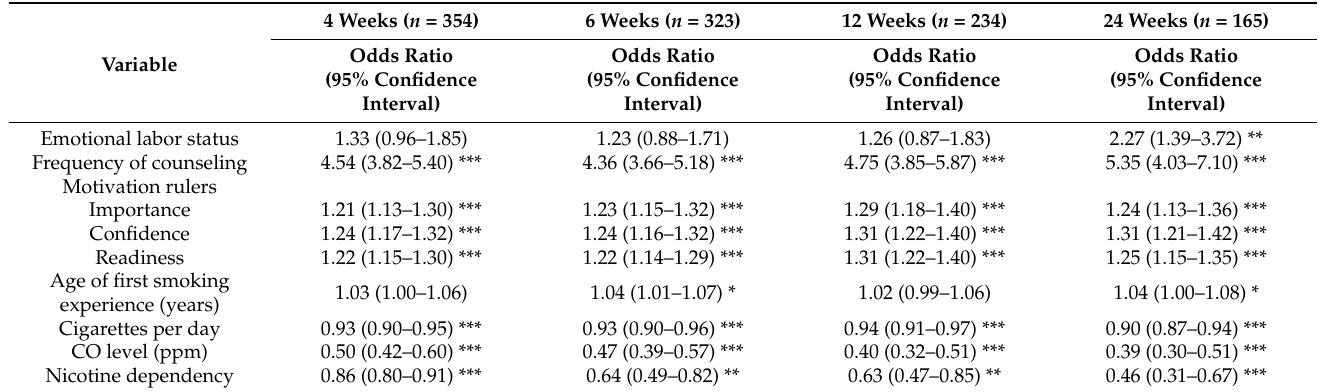
Table 5. The factors associated with successfully of quitting